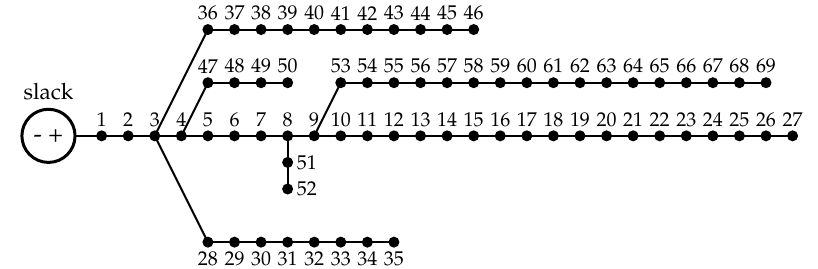
Figure 2. Schematic connection among nodes for the 69-node test feeder. Table 2. Parametric information of the 69-node test